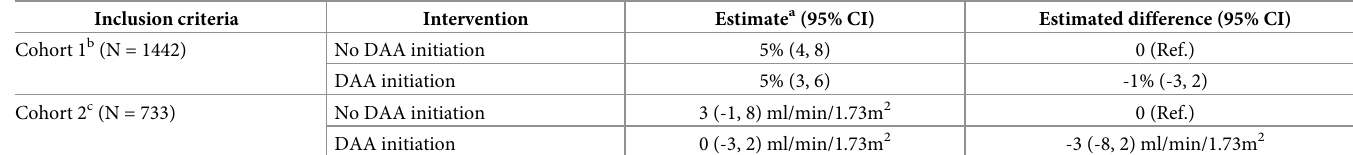
Table 2. Estimated causal effect of DAA initiation interventions on kidney function stratified by baseline renal function. Inclusion